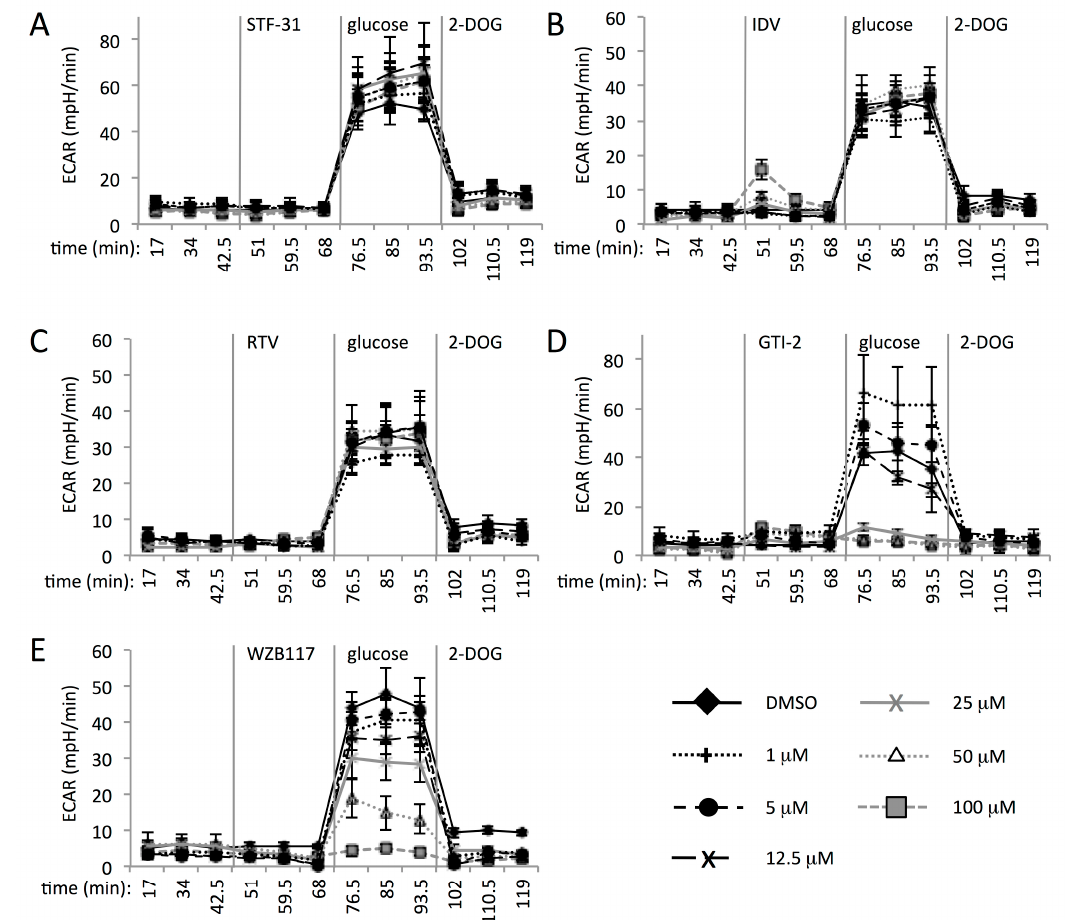
Figure 2. Blocking glucose uptake by CD4+ T cells requires inhibitors that target multiple GLUT proteins. The extracellular acidification rate (ECAR in mpH per min) was determined in real time for activated CD4+ T cells in the absence of glucose, followed by sequential injection of GLUT inhibitor at 0, 1, 5, 12.5, 25, 50, and 100 µ M; glucose (1 g/L); and 2-deoxyglucose (4.5 g/L). ( a ) STF-31; ( b ) Indinavir (IDV); ( c ) Ritonavir (RTV); ( d ) GTI-2; ( e ) WZB117. The data shown are representative experiments from replicates with three to five different donors.